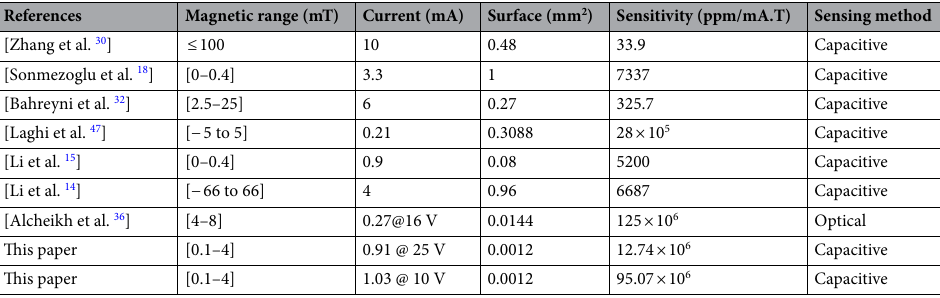
Table 1. Summary of the sensor’s performance of this work compared with some of the reported frequency modulation (FM) Lorentz-force-based magnetic